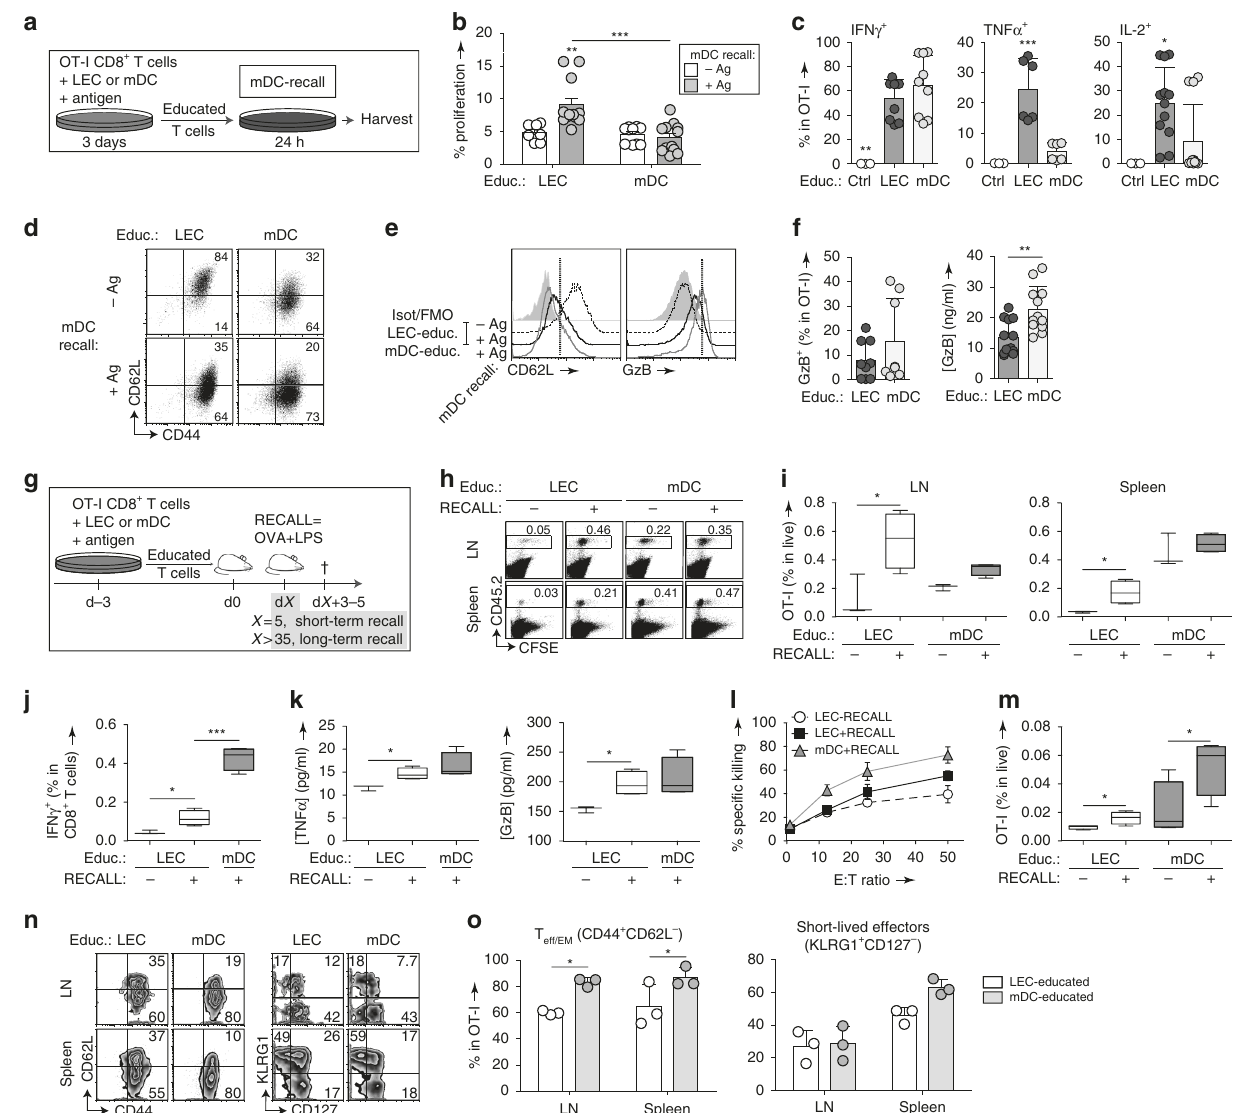
Fig. 7 LEC-educated CD8 + T cells expand rapidly and differentiate into effector cells upon secondary challenge. a Experimental setup for b – f : CFSE- labeled LEC/mDC-educated cells were recalled with Ag-pulsed or control mDCs. b Percentage of CD8 + T cells that were proliferating at endpoint. c Frequency of IFN γ + , TNF α + , and IL-2 + cells among live OT-I cells. d Representative dot plots depicting CD62L and CD44 expression gated on OT-I cells depending on initial education conditions and antigen recall, and e according histograms depicting CD62L and GzB expression. f Frequency of intracellular GzB + OT-I cells and production of GzB detected by ELISA in cell culture supernatants. g Experimental setup for h – o : CFSE-labeled CD45.2 + LEC/mDC-educated OT-I cells were transferred into CD45.1 + wild-type adult mice, and recalled with OVA/LPS at the short-term (5 days post-transfer, h – l ) or long-term (>5 weeks post-transfer, m – o ) memory phases. As a negative control, some recipients received a mock buffer injection (RECALL: − ). h CFSE dilution on transferred cells recovered from LNs or spleens. i Composition of transferred cells among all live cells in the LNs or spleen. j Frequency of intracellular IFN γ + cells among transferred cells. k Endpoint concentrations of TNF α and GzB production after ex vivo re-stimulation. l Cytotoxicity of recalled LEC-educated vs. mDC-educated OT-I cells measured based on speci fi c killing of antigen-pulsed target cells relative to non-speci fi c killing of scrambled peptide-pulsed target cells. E:T = effector to target cell ratio. m Composition of OT-I cells among live cells in the LNs after long-term recall. n Representative fl ow cytometry plots depicting expression of CD44, CD62L, CD127, and KLRG1 gated on OT-I cells. o Frequency of T eff/EM (CD44 + CD62L − ) and short-lived effectors (KLRG1 + CD127 − ) within OT-I cells. Data points and error bars indicate mean±SD for n = 3 – 7 biological replicates pooled from up to three independent experiments. Whiskers: Min to Max, median i – k , m . * p ≤ 0.05, ** p ≤ 0.01, *** p ≤ 0.001 by two-way ANOVA b , l , o , one-way ANOVA with Bonferroni ’ s post-test c , or by two-tailed unpaired Student ’ s t -test f , i – k , m